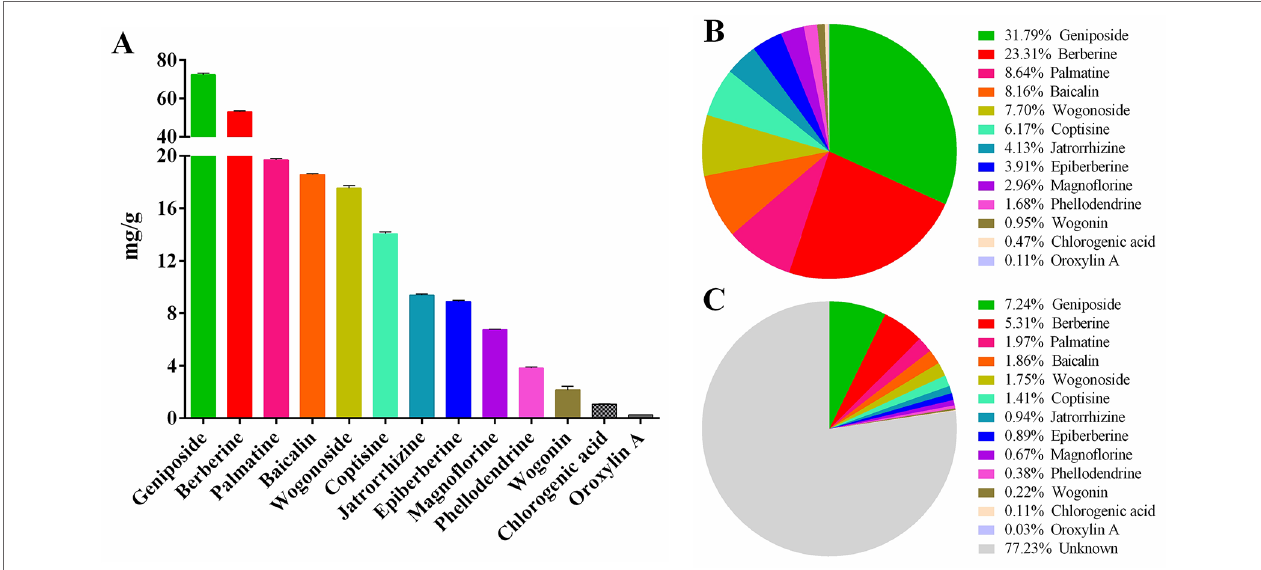
FIgURE 2 | Contents of 13 active ingredients in HLJDD. (A) The content of 13 active ingredients in HLJDD. (B) The percentage of each active ingredient in the total 13 active ingredients. (C) The percentage of 13 active ingredients in HLJDD.